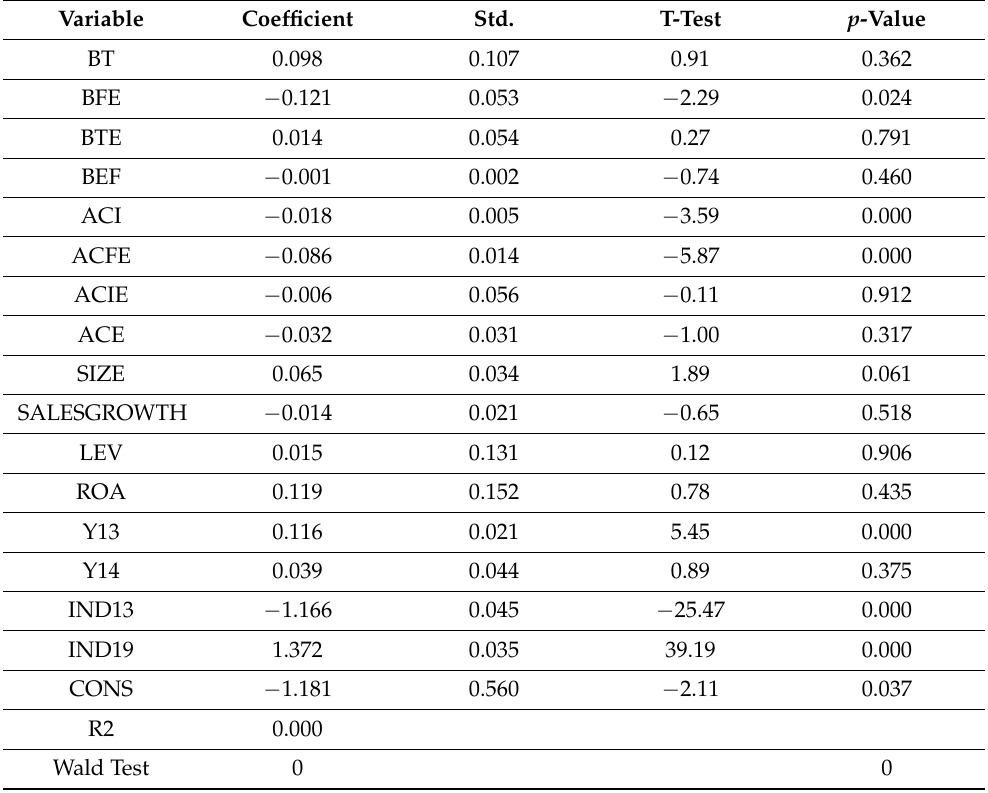
Table 21. The outcome of the T + 1 regression estimation of model two by the fixed-effects approach.